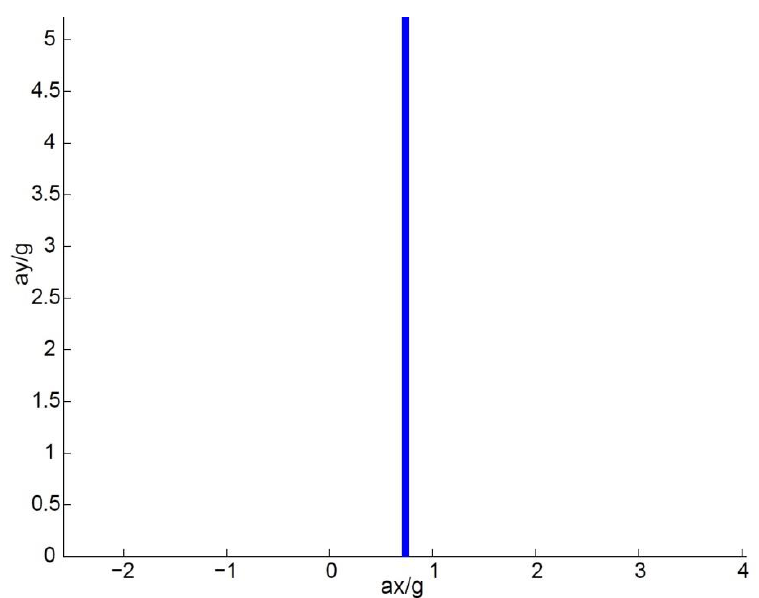
Figure 2. Power limit for v = 50 km/h.